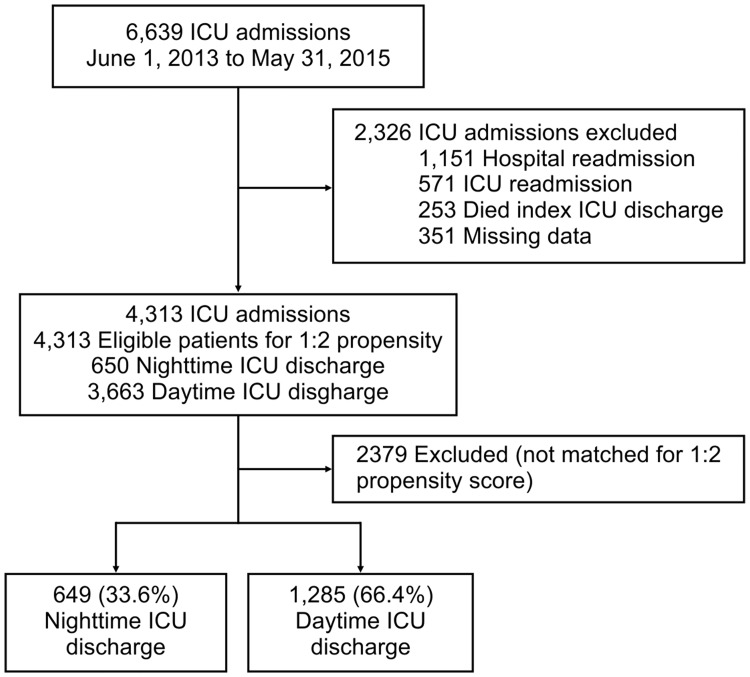
Patient flow charge.